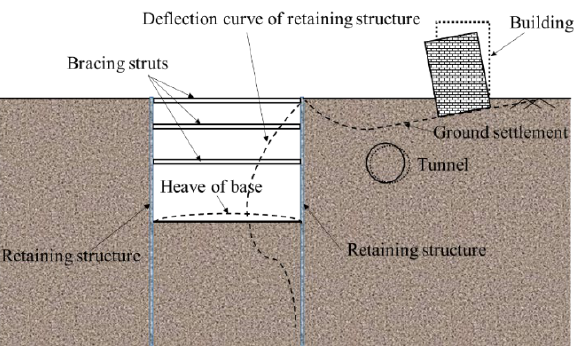
Figure 1. Response of surrounding environment induced by an excavation.